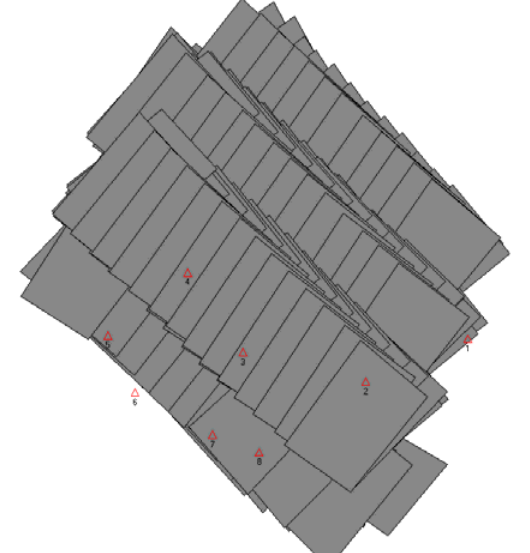
Figure 4: Orthophotomosaic computed in PhotoScan (Agisoft) together with check-points (yellow